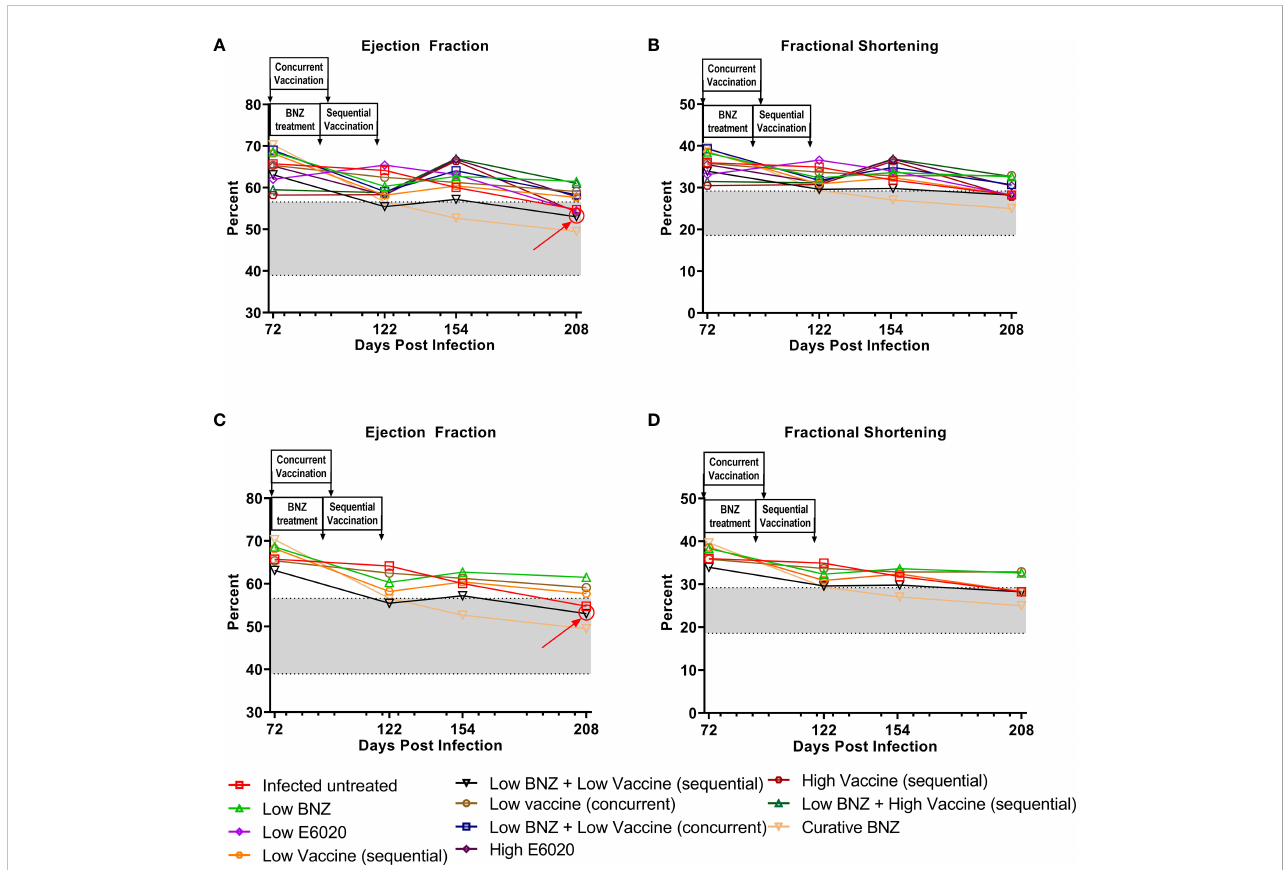
FIGURE 6 Ejection fraction and fractional shortening after treatment. M-mode images from echocardiographic examination were used to measure left ventricular ejection fraction (EF, panel A ) and fractional shortening (FS, panel B ) in naïve, infected untreated and treated mice at 70dpi, 122dpi, 154dpi and 208dpi. Panels (C) and (D) illustrate only a subset of treatment groups to better visualize treatment differences between key groups. The grey shaded area represents the mean ± SD of the EF and FS measurements from naïve age matched